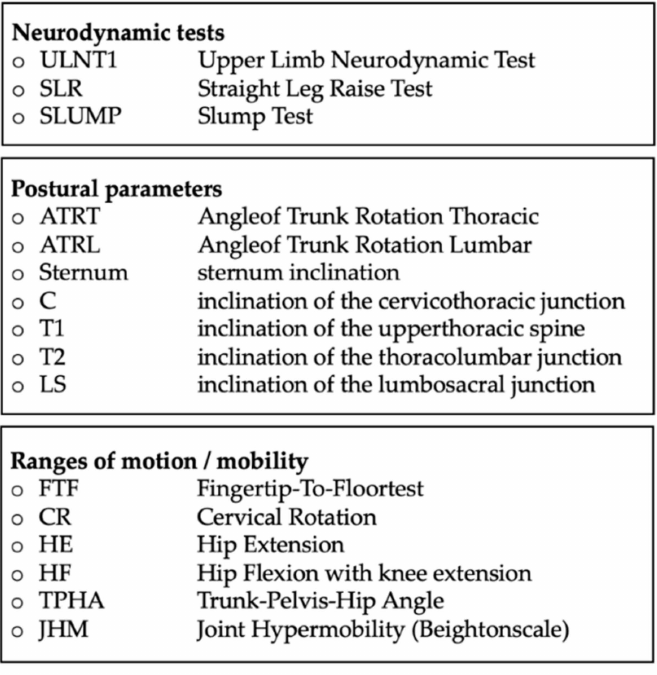
Figure 1. List of abbreviations for parameters used in this